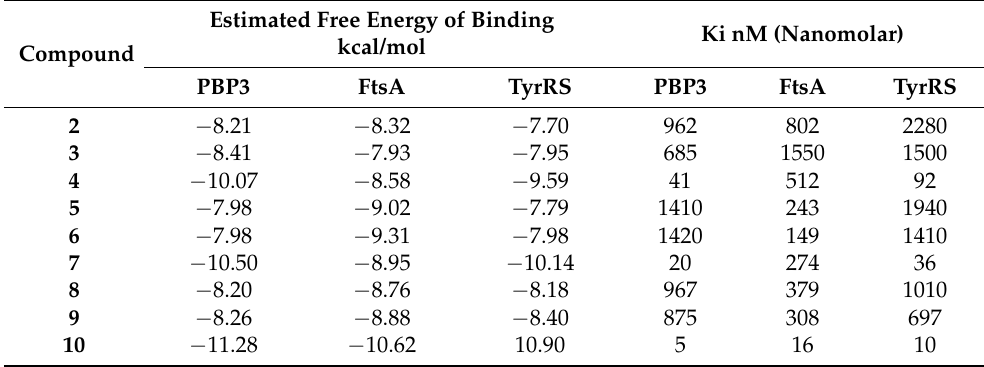
Table 7. Estimated free energy of binding and estimated inhibition constant (Ki) for compounds 2 – 10 when interacting with protein targets PBP3, FtsA, and TyrRS from Staphylococcus aureus